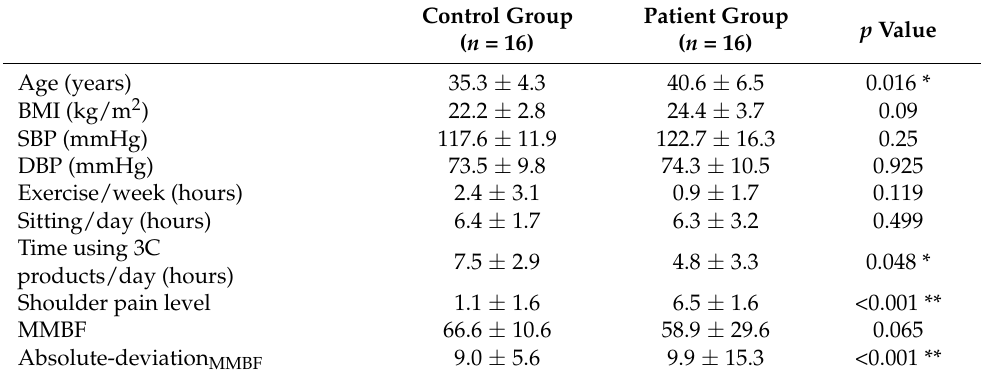
Table 1. Differences in physiological parameters, life characteristics, shoulder pain level, and mean microcirculation blood flow (MMBF) between the patient and control groups.